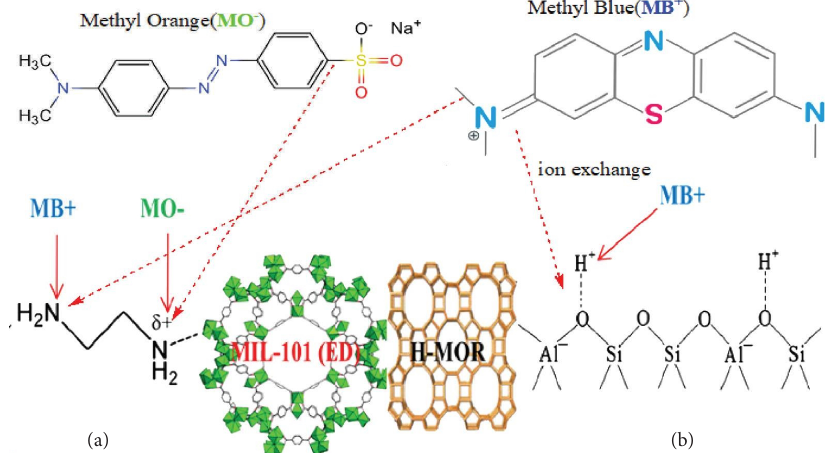
Figure 34: Te adsorption mechanisms of dyes: (a) electrostatic interaction between anionic MO and cationic MIL-101-ED. (b) Ion exchange between H + ions in HMOR with cationic MB modifed from [1].